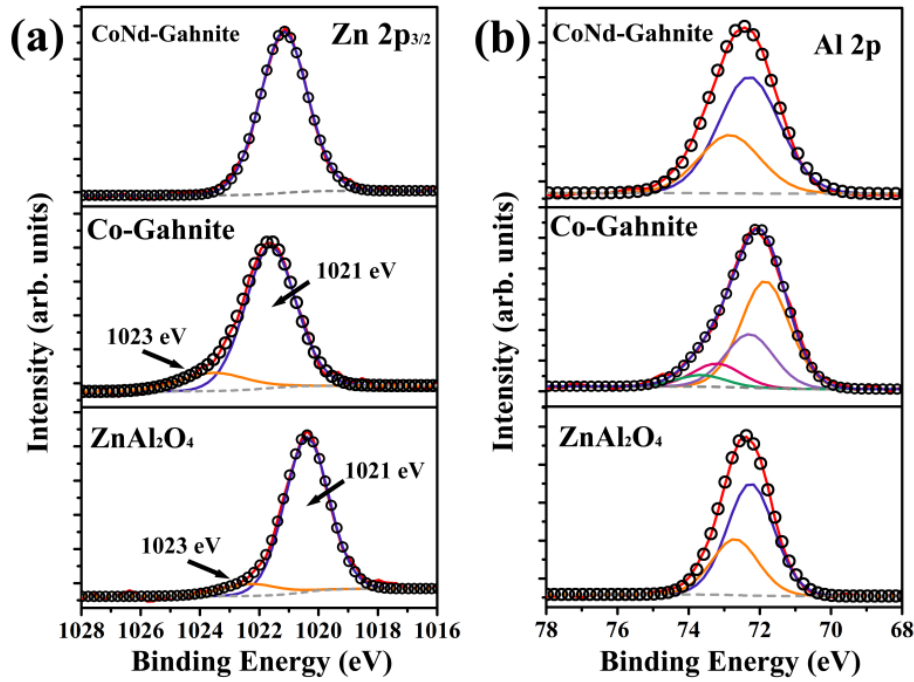
Figure 4. XPS analysis of ZnAl 2 O 4 , Co-Gahnite, and CoNd-Gahnite pigments. The experimental solid line and fitted curves of high-resolution XPS spectra of ( a )Zn 2p 1/2 ; and ( b ) Al 2p. The high energy resolution photoelectron spectra of O 1s are shown in Figure S1. The O 1 s peak is fitted with two components (Figure S1). The component centered at 530.8 eV was assigned to oxygen atoms participating in Zn-O and Al-O bonds in the ZnAl 2 O 4 lattice. The low-intensity component centered at 532.7 eV indicates an oxygen deficiency in the ZnAl 2 O 4 crystal lattice [26]. The fitting analysis of the Co 2p core level is shown in Figure S2, which was performed to evaluate the oxidation state of cobalt in the Gahnite structure. The XPS analysis indicated that the most prominent cobalt species present in the Gahnite structure was Co 3 O 4 [27], which confirmed the presence of cobalt in mixed oxidation states of 2+ and 3+ at the surface of the agglomerates. The K/S absorption spectra were recorded in the wavelength range of 300–800 nm to study the optical properties of the pigments (Figure 5). The graphic shows the triplet d-d band located at 548 (green region), 582 (yellow-orange region), and 622 nm (red region), which gives rise to the blue coloration [28]; this triplet is assigned to the 4 A 2 (4F) → 4 T 1